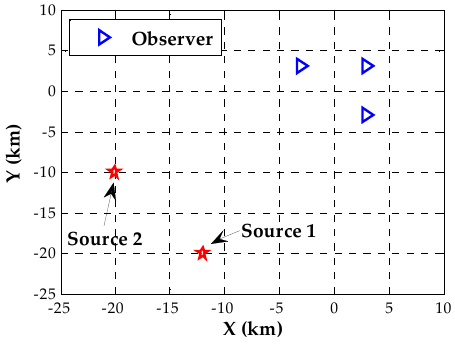
Figure 7. Scenario of three observers and two far-field sources placed on the ground.